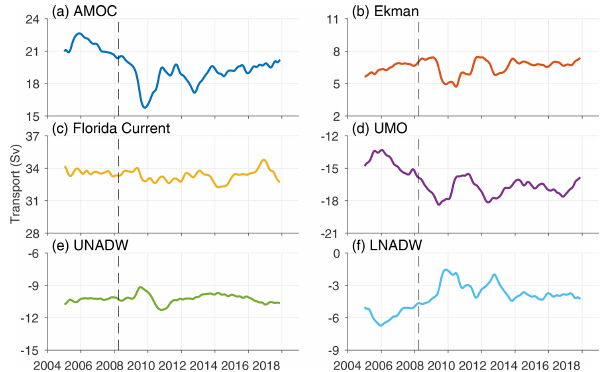
Figure 4. Interannual variability of the AMOC at 26 ◦ N and its component parts: (a) AMOC, (b) Ekman, (c) Florida Current, (d) upper mid-ocean (UMO), (e) upper North Atlantic Deep Water (UNADW) and (f) lower North Atlantic Deep Water (LNADW).